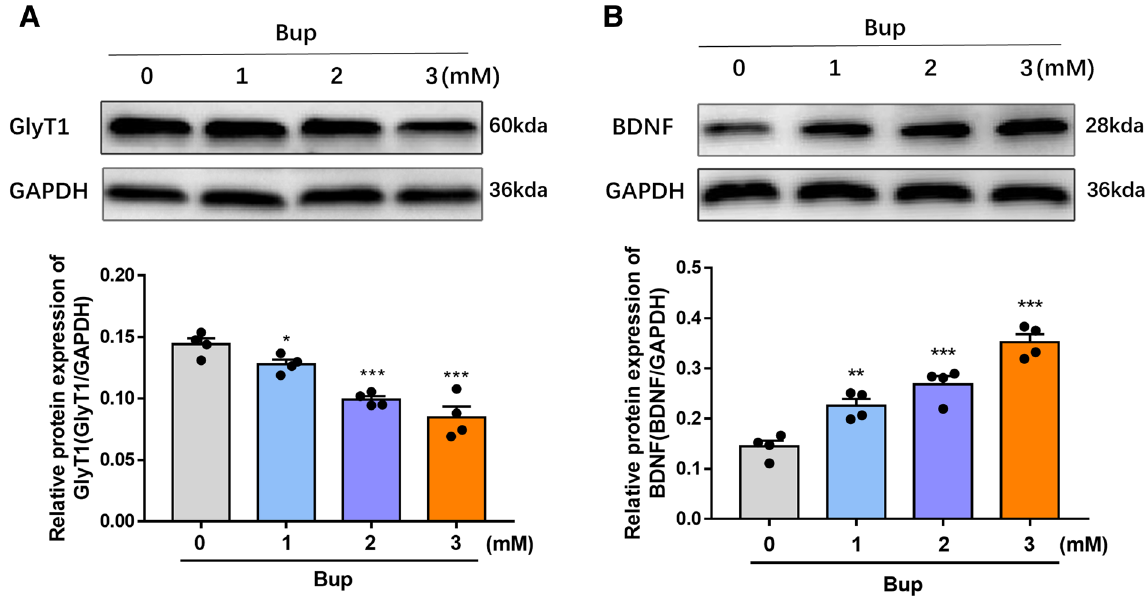
Figure 1. Bupivacaine regulated GlyT1 and BDNF expression in astrocytes. ( A , B ) Representative western blotting and quantification of GlyT1 and BDNF expression. * p < 0.05, ** p < 0.01, *** p < 0.001 vs. the control group. Data are expressed as the mean ± SEM. Original images of gels/blots are available in Supplementary Fig S1. Bup,